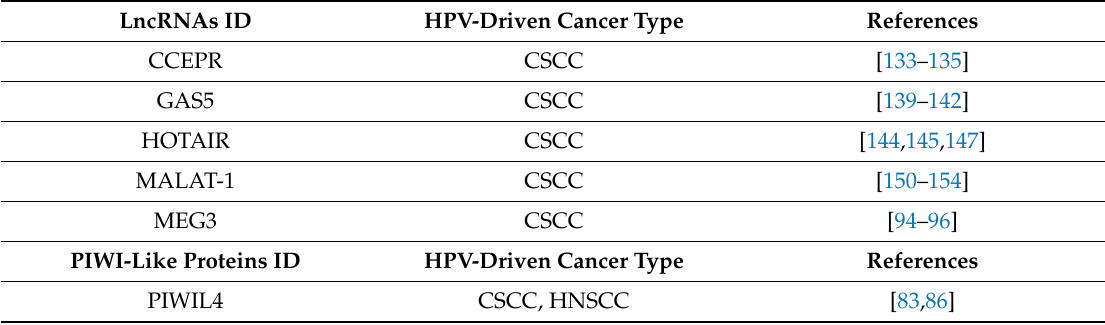
Table A1. Long non-coding RNAs (lncRNAs) and PIWI-like proteins deregulated in two or more di ff erent